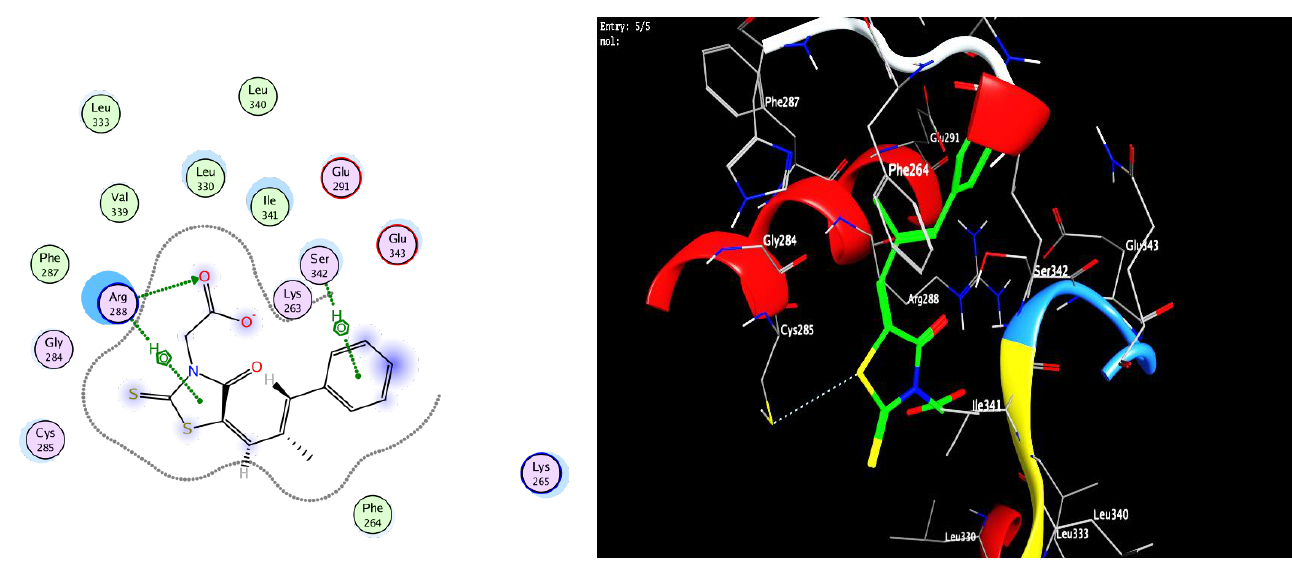
Figure 10. 2D and 3D docking of compound Epalrestat with AKR1B10.